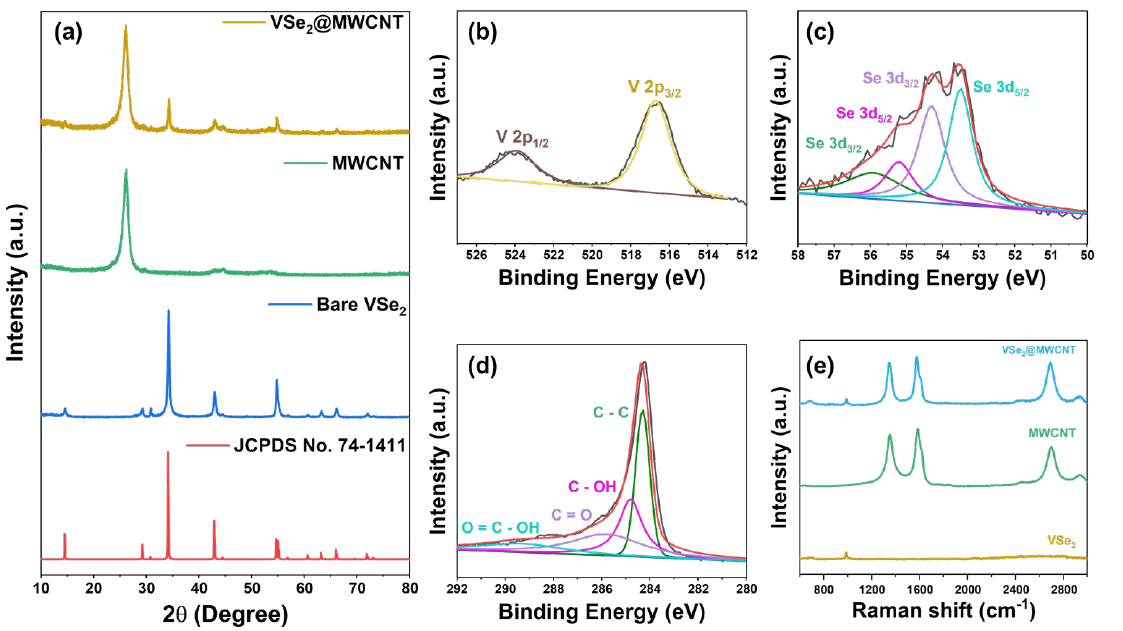
Figure 3. Crystallinity and composition. ( a ) XRD patterns of the VSe 2 , MWCNT, VSe 2 @MWCNT. ( b ) XPS V 2p, ( c ) XPS Se 3d 5/2 and 3d 3/2 ( d ) XPS C 1s of the VSe 2 @MWCNT, ( e ) Raman spectrum of the VSe 2 @MWCNT.